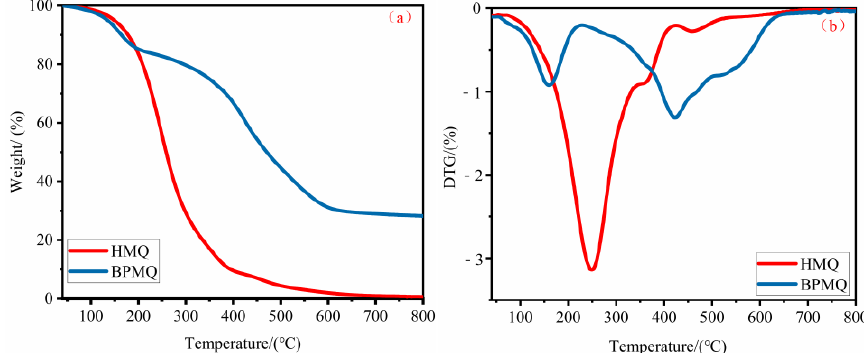
Figure 5. TG ( a ) and DTG ( b ) curves of HMQ and BPMQ, obtained in a nitrogen atmosphere.